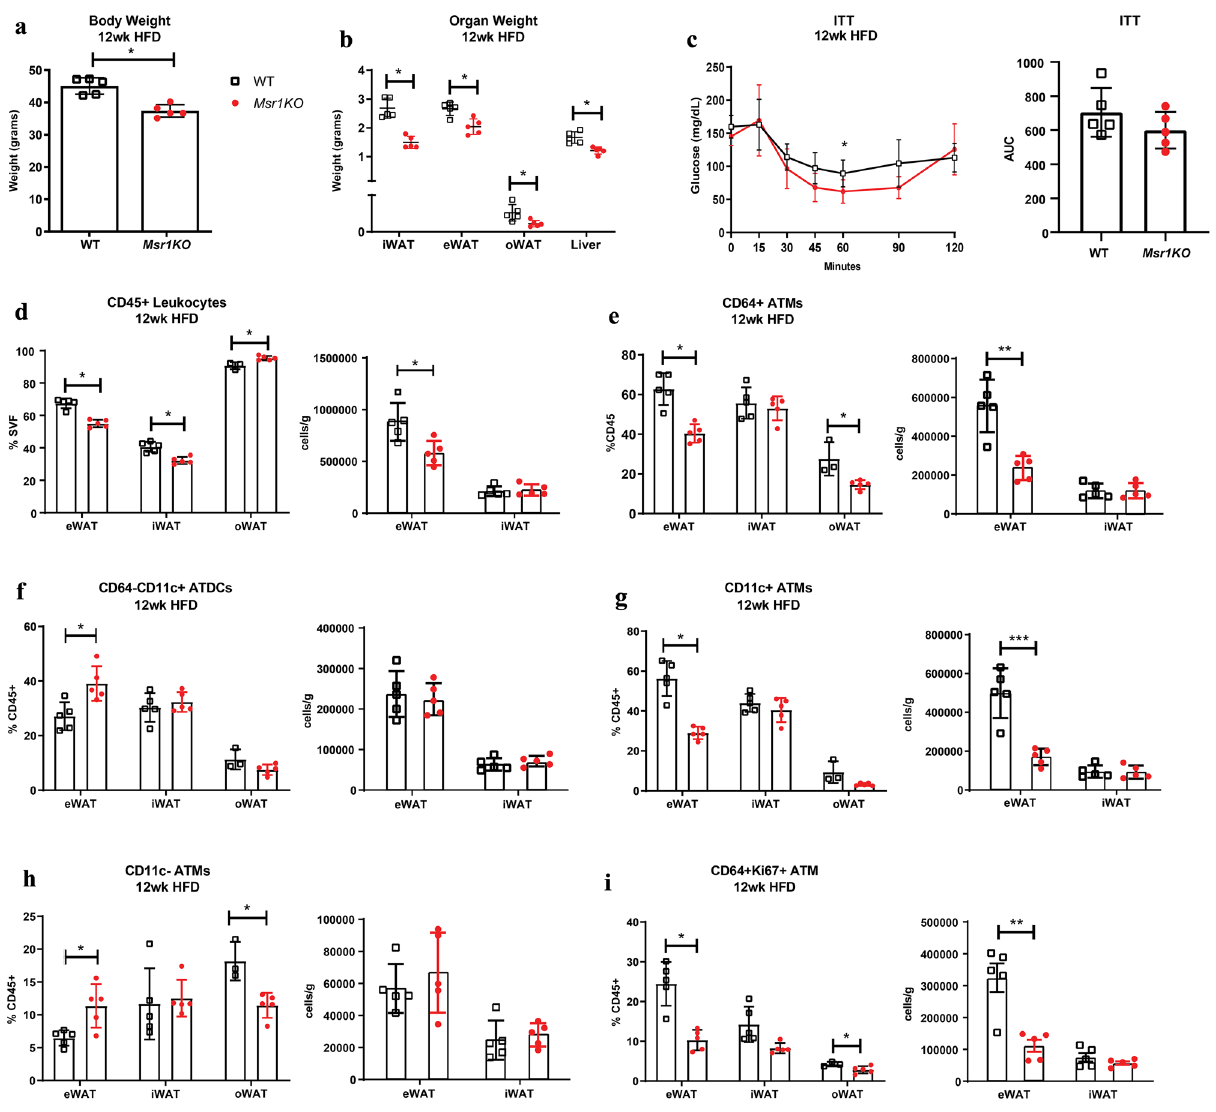
Figure 2. Male Msr1KO mice have decreased fat mass and inflammation compared to non-littermate wild- type controls. ( a ) Whole body weight for 12-week HFD fed Msr1KO (red) and C57BL6 wild type non-littermate controls (white). ( b ) Organ weight for Msr1KO (red) and WT non-littermate controls (black). ( c ) Insulin tolerance test (ITT) after 12 weeks of HFD. Flow cytometry analysis of ( d ) CD45 + leukocytes, ( e ) CD64 + ATMs, ( f ) CD64 − CD11c + ATDCs, ( g ) CD11c + ATMs, ( h ) CD11c + ATMs, and ( i ) CD64 + Ki67 + ATMs in SVF after 12 weeks of HFD. n = 5/group. * p < 0.05. Statistical Analysis = T-test. Identical results observed when data was expressed as percent total SVF